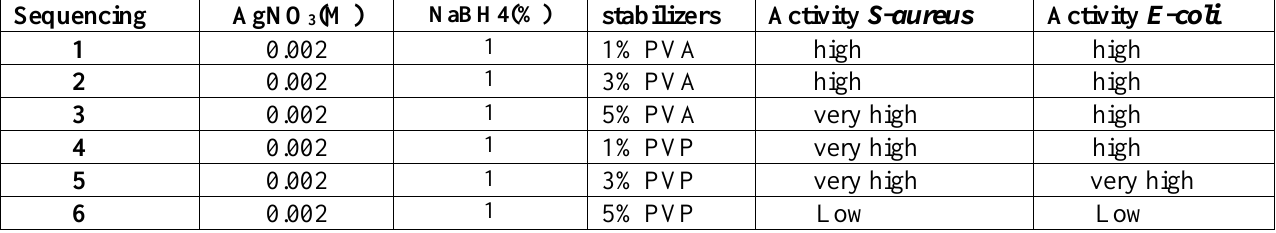
Table 3: Show the effect of each concentration and its activity against bacteria